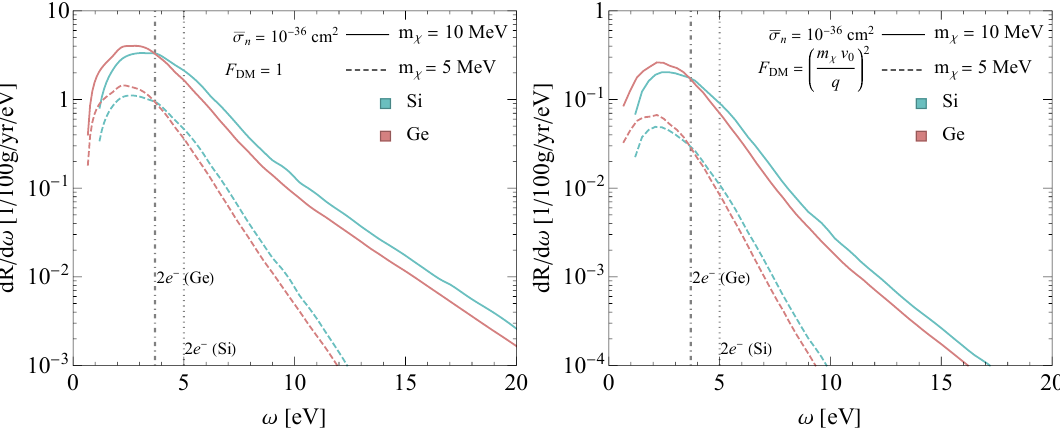
Figure 5. The differential DM-nucleus Migdal scattering rate expected for 100 g of material and 1 year of exposure, computed for a heavy ( left panel ) and a light ( right panel ) mediator, for silicon ( cyan ) and germanium ( red ), and for two different DM masses, m χ = 5 MeV ( dashed ), and m χ = 10 MeV ( solid ). The DM-nucleon reference cross-section defined below eq. (5.3) is set to ¯ σ n = 10 − 36 cm 2 . The vertical lines indicate the approximate ionization threshold required to produce two electron-hole pairs in the detector for silicon ( dotted , 5 . 0 eV) and germanium ( dot- dashed , 3 . 7 eV)